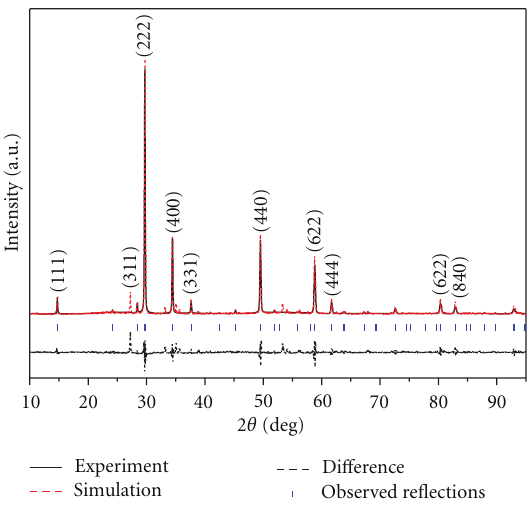
Figure 2: Pawley refinements of XRD data for novel photocatalyst Fe 2 BiSbO 7 prepared by the solid state reaction method at 1020 ◦ C. The solid line represents experimental X-ray di ff raction pattern (—). The dot line represents simulation X-ray di ff raction pattern ( ... ). The tic marks represent reflection positions. A di ff erence (observed-calculated) profile is shown beneath. Table 1: Atomic coordinates and structural parameters of Fe 2 BiSbO 7 prepared by the solid state reaction method.